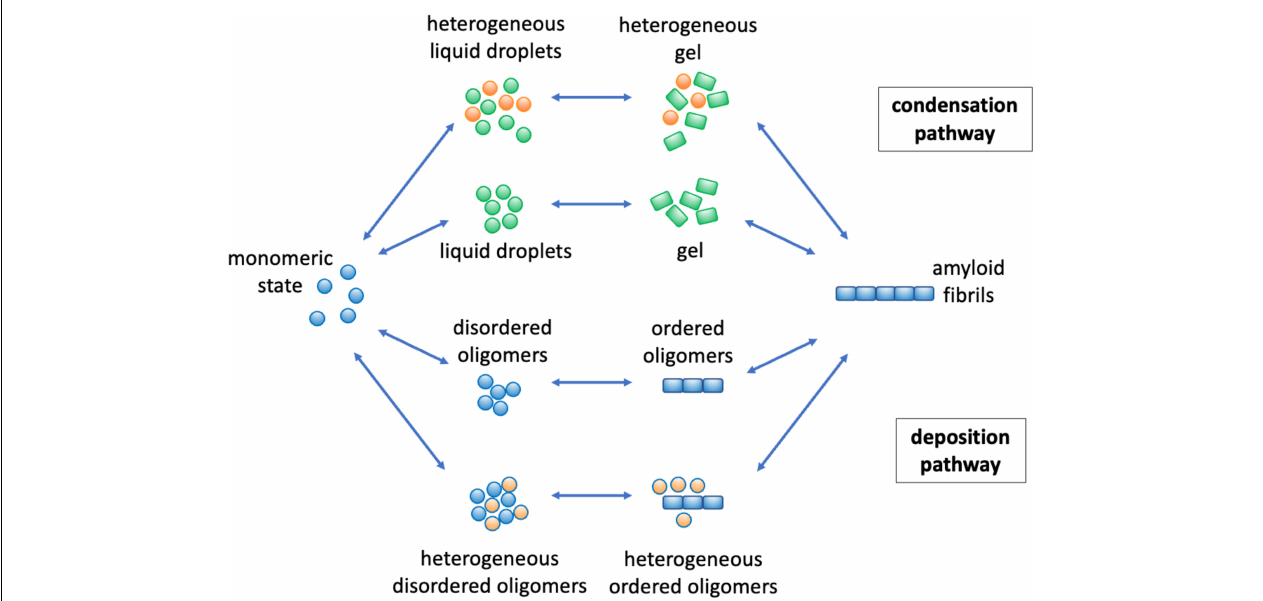
FIGURE 3 | Mechanisms by which lipids can affect protein aggregation through the deposition and condensation pathways. The protein aggregation process can take place through two major pathways. In the deposition pathway (Knowles et al., 2014; Selkoe and Hardy, 2016) (lower part) monomeric proteins initially self-assemble into disordered oligomeric species, while in the condensation pathway (Hyman et al., 2014; Banani et al., 2017; Boeynaems et al., 2018) (upper part) the initial formation of liquid droplets facilitate the formation of disordered oligomers. These early disordered oligomers can then convert into more ordered forms (Cremades et al., 2012; Michaels et al., 2020), which can grow into amyloid fibrils. The overall aggregation process can be facilitated, both thermodynamically and kinetically ( Box 1 ), by the presence of lipids (in orange) both in the deposition (Habchi et al., 2018) and in the condensation (Ray et al., 2020; Hardenberg et al., 2021) pathways. Kinetically, lipids may catalyze the different conversion steps, and thermodynamically they can stabilize heterogeneous species of mixed